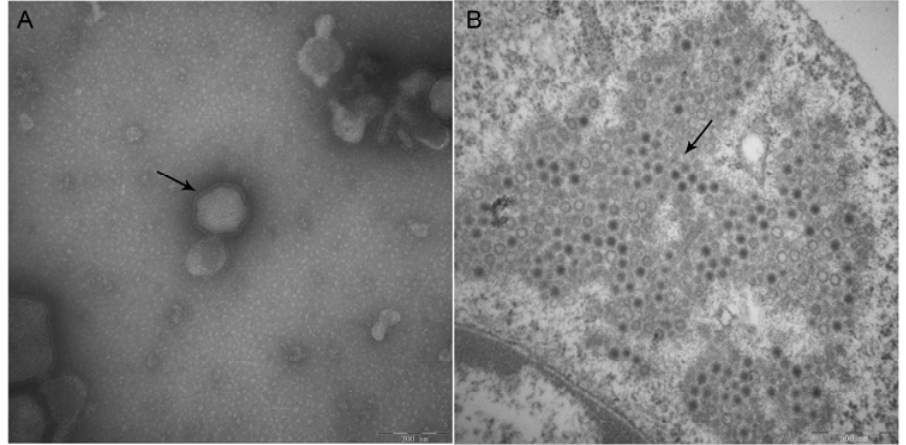
Figure 3. Images of PEDV strain NJ particles and PEDV strain NJ ‐ infected IEC produced by electron microscopy. ( A ) Virions in culture media of IECs infected with PEDV strain NJ, as shown by the arrow; Bar = 200 nm. Magnification, ×100,000; ( B ) Thin section of IECs infected with PEDV strain NJ 24 h post ‐ infection; many of the virus particles possessed a dense core and gathered in the cytoplasm as shown by the arrow; Bar = 500 nm. Magnification, ×50,000.